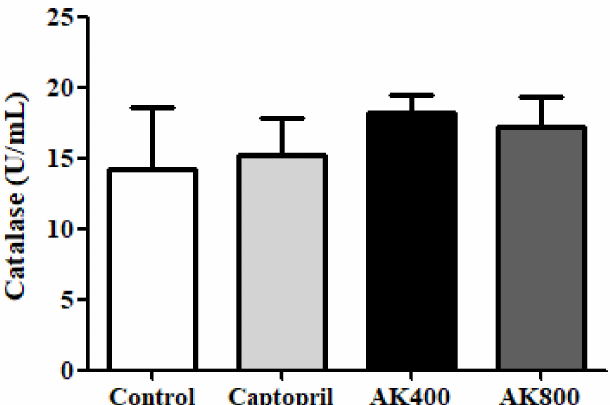
Figure 4. Catalase activity in the SHR brains. The groups are the control (distilled water), captopril (20 mg / kg body weight), AK3K400 (400 mg / kg body weight), and AK3K800 (800 mg / kg body weight). Data are presented as mean ±